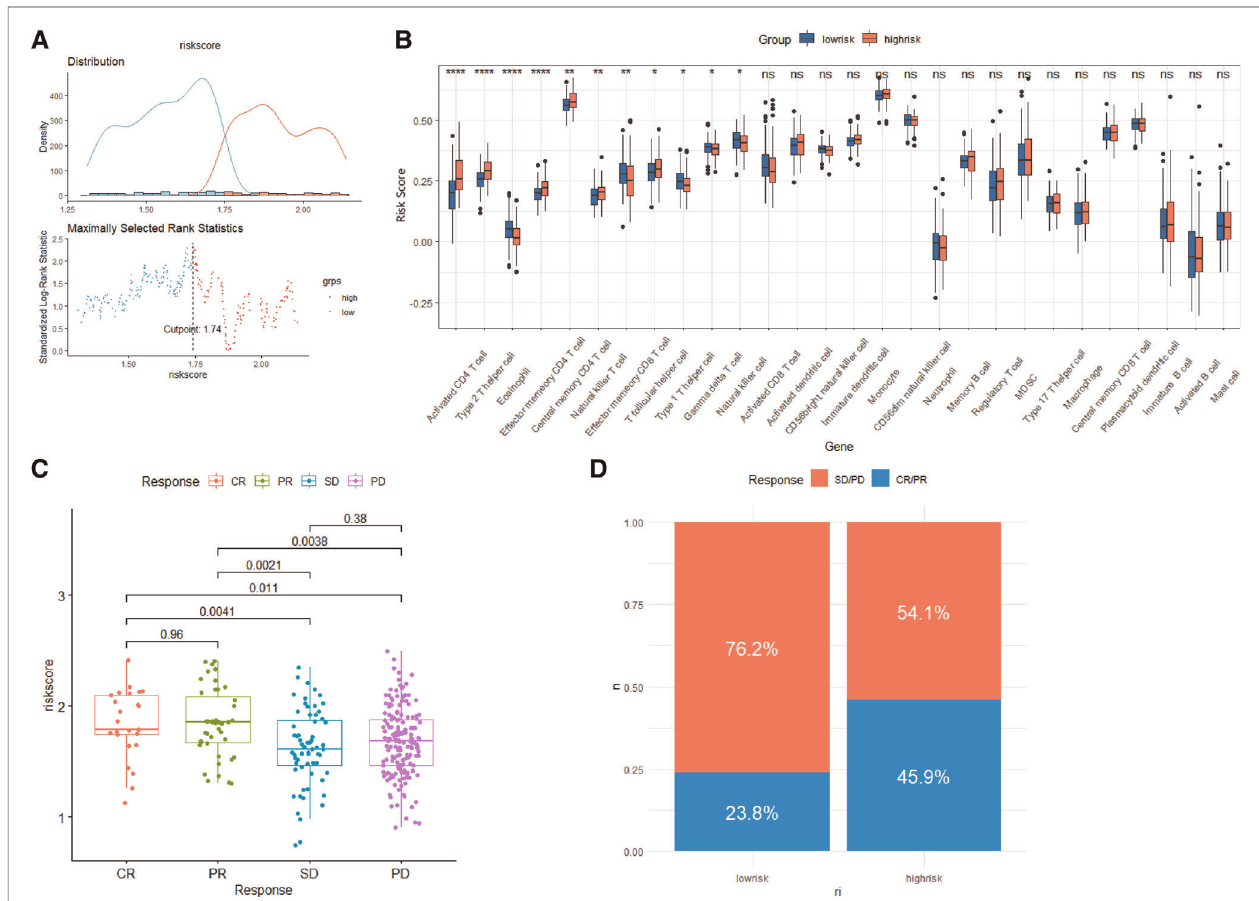
FIGURE 13 | Role of the Risk Score Signature in immunotherapeutic responses. ( A ) Determination of cutoff. ( B ) Differences in 28 TME in fi ltration cells between low- and high-risk groups. ( C ) Relationship between the Risk Score Signature and anti-PD-L1 clinical response. ( D ) Proportion of patients responding to anti-PD-L1 therapy in low- or high-risk